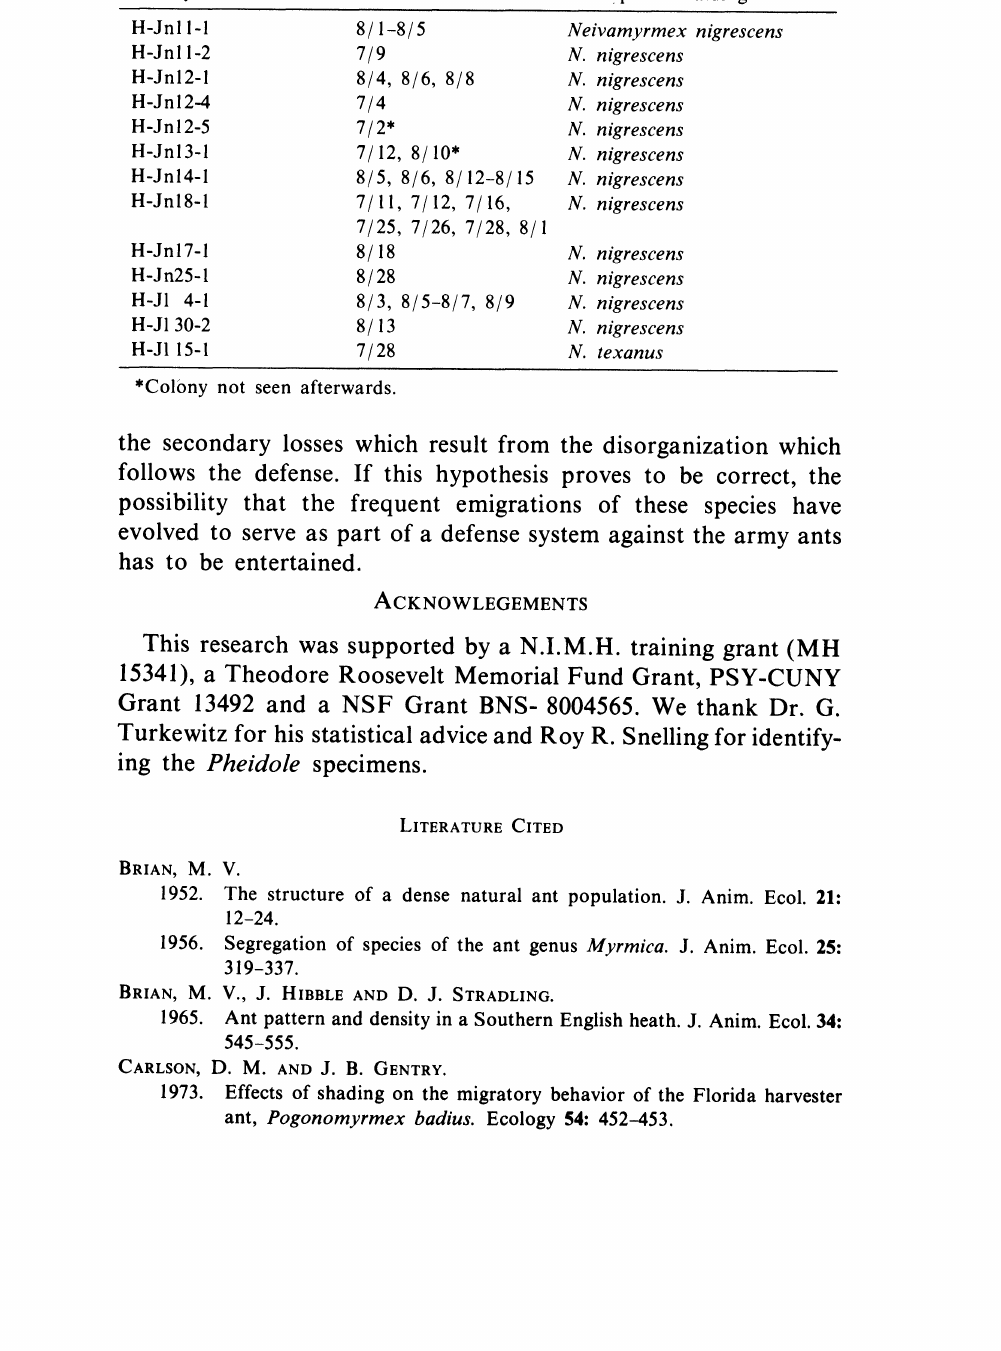
Table 4. Observed army ant raids on colonies of P. desertorum.